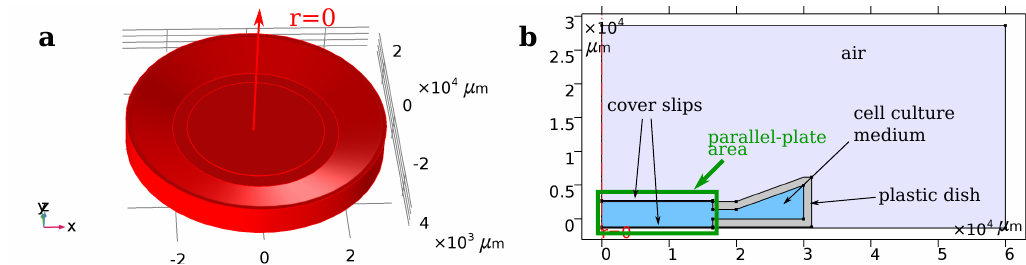
Figure 2. General geometry of the simulation model. ( a ) 3D representation of the axisymmetric set-up, consisting of ( b ): air, culture medium/buffer (blue), plastic dish (grey), and symmetry axis (red). The voltage is applied between the top side of the upper cover slip and the bottom side of the lower cover slip. The area highlighted in green is the area for which the parallel-plate capacitor approximation was